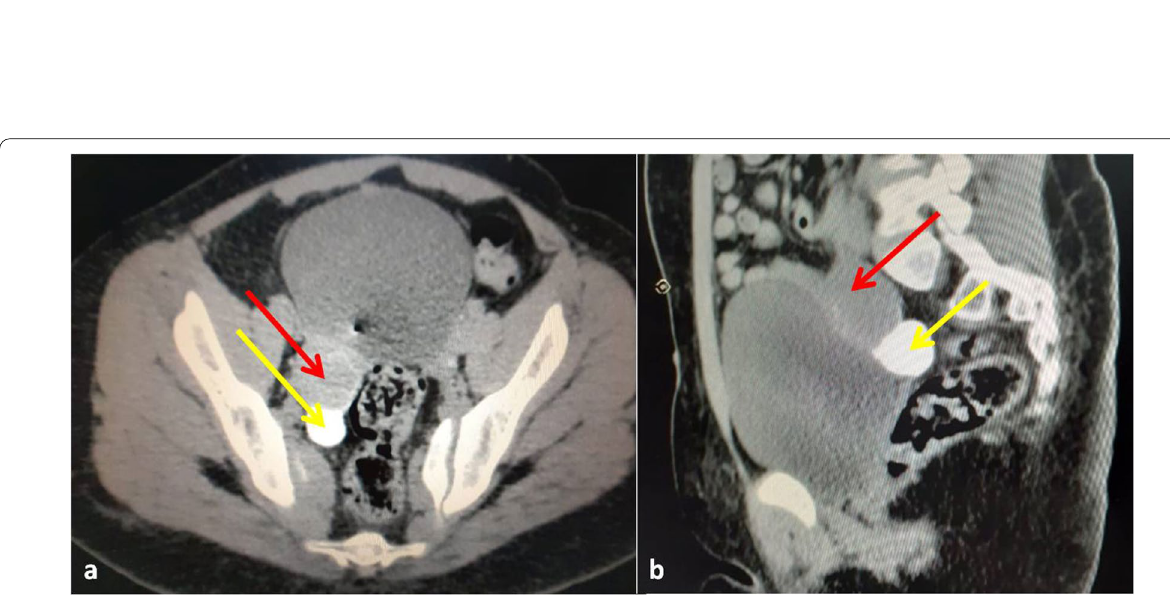
Fig. 3 Complementary CT confirmed the presence of a right adnexal calcified part (yellow arrow). The anterosuperior part of the right adnexal lesion appeared to have soft-tissue attenuation with faint incomplete marginal calcifications (red